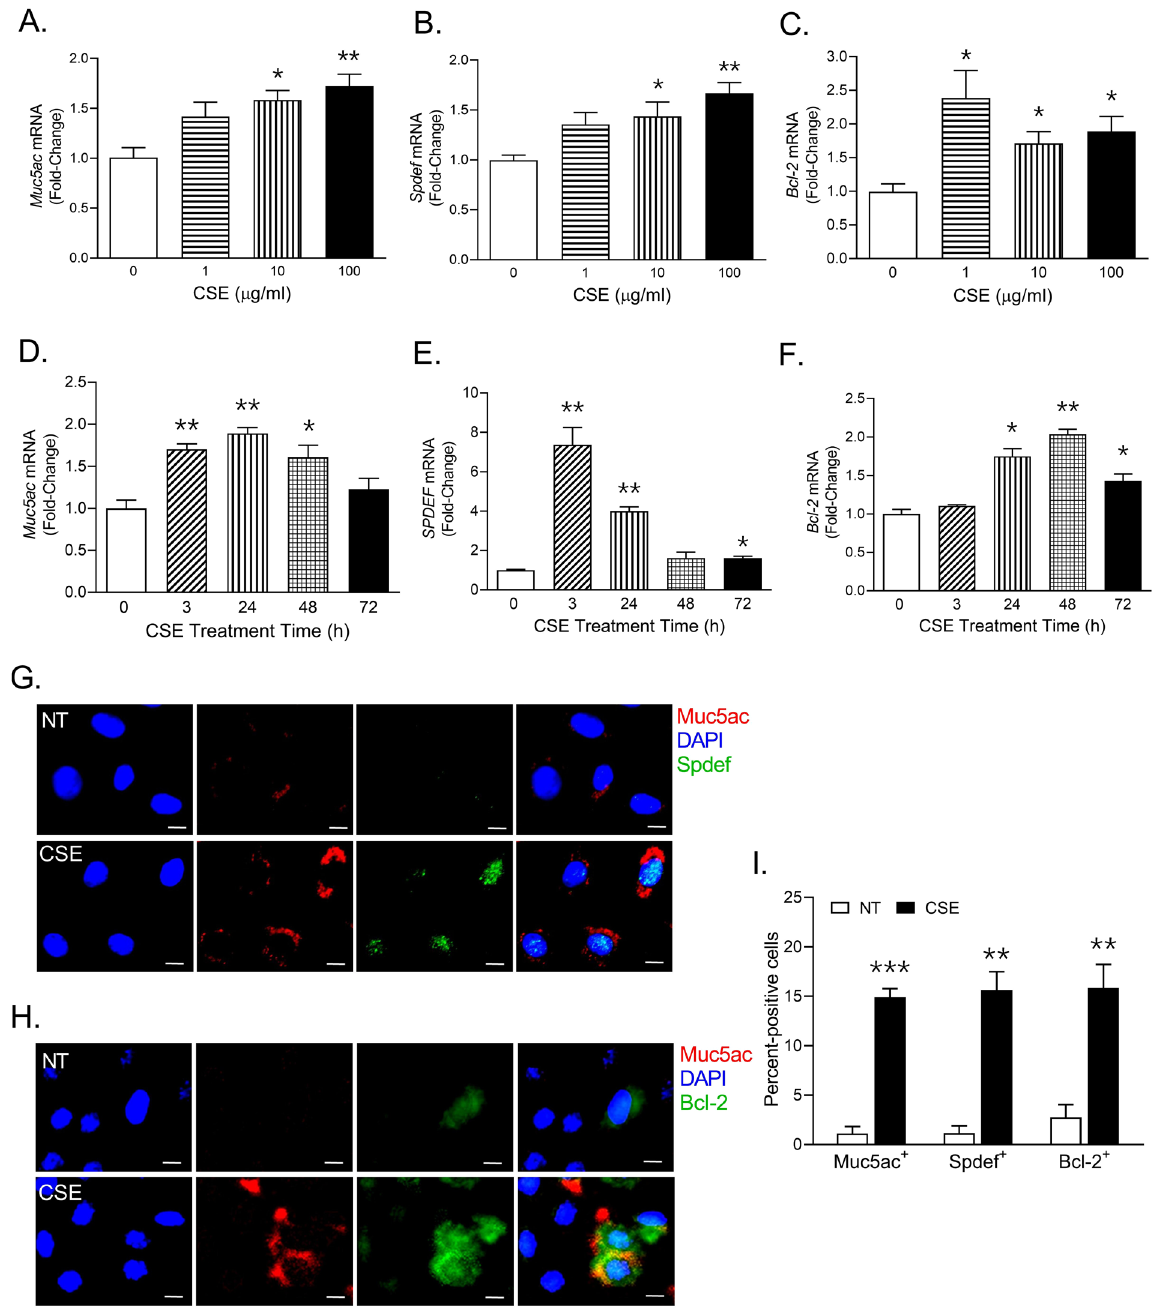
Figure 1. CS exposure induces mucous phenotype and Bcl-2 levels in murine airway epithelial cells (AECs). Primary murine AECs were treated with cigarette smoke extract (CSE) at 0, 1, 10, and 100 µ g/ml for 24 h and the mRNA levels of Muc5ac ( A ) Spdef ( B ) and Bcl-2 ( C ) were analyzed by qRT-PCR. Murine AECs treated with 10 µ g/ml CSE and cells were harvested at 0, 3, 24, 48 and 72 h and mRNA levels of Muc5ac ( D ) Spdef ( E ) and Bcl-2 ( F ) were quantified. ( G ) Representative micrographs showing Muc5ac (red) and Spdef (green) expression in murine AECs following CSE treatment in comparison with non-treated (NT) cells. Murine AECs were treated with CSE (10 µ g/ml) for 48 h and immunostained for Muc5ac and Spdef, and the nuclei (blue) were stained with DAPI (Scale – 5 µ ). ( H ) Representative micrographs showing Muc5ac (red) and Bcl-2 (green) expression in CSE-treated and treated (NT) murine AECs, nuclei were stained with DAPI (Scale – 5 µ ). ( I ) Quantification of Muc5ac, Spdef and Bcl-2 immunopositive cells following CSE exposure. Approximately 300 cells from each treatment were analyzed to calculate the percentage of Muc5ac-positive (Muc5ac + ), Spdef-positive (Spdef + ) and Bcl-2-positive (Bcl-2 + ) cells. Data shown as mean ± SEM (n ≥ 3); * p < 0.05; ** p < 0.01; *** p <